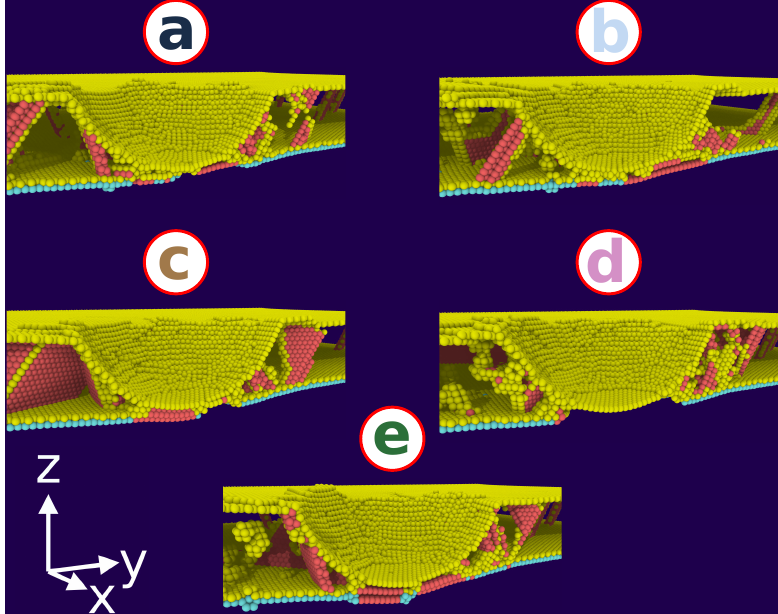
Figure 6. Snapshots showing the microstructure induced in Ni containing a 30 ◦ hm grain boundary at the indentation points, a–e , of Figure 5. Colors denote lattice defects as in Figure